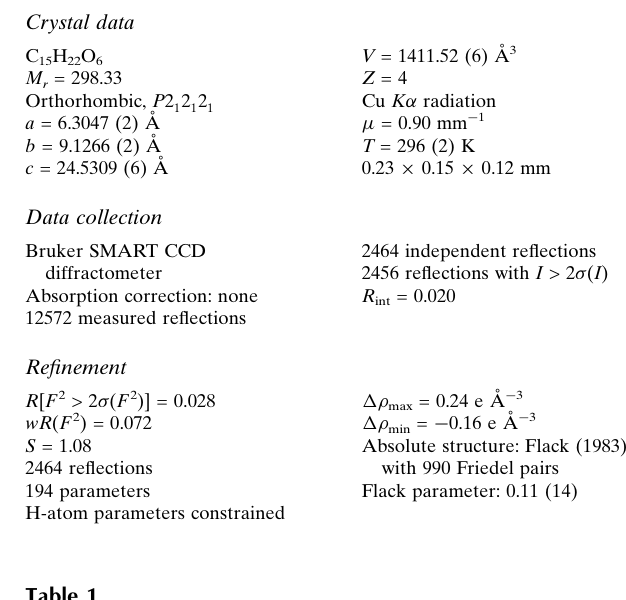
Hydrogen-bond geometry (A˚ , (cid:4)